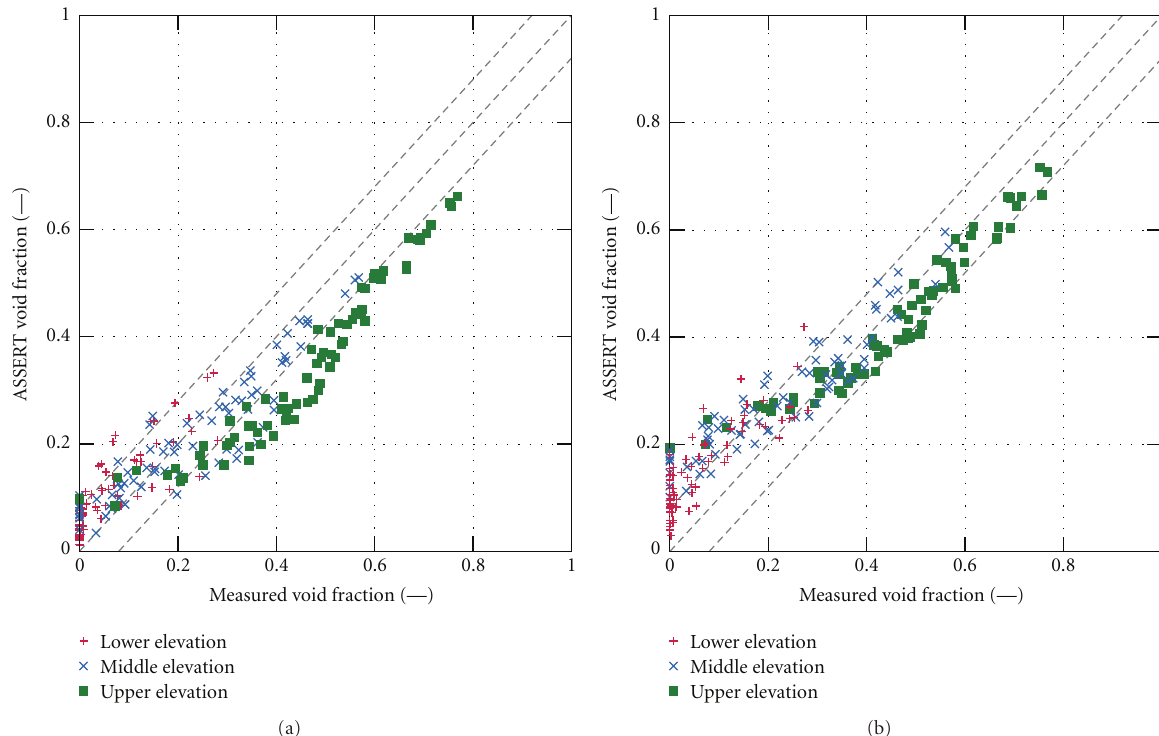
Figure 12: Steady state void fraction results for bundle B5 using the Chen (a) and Lahey (b) two-phase heat transfer correlations. Error bands displayed correspond to 2 σ exp = 0 . 08.